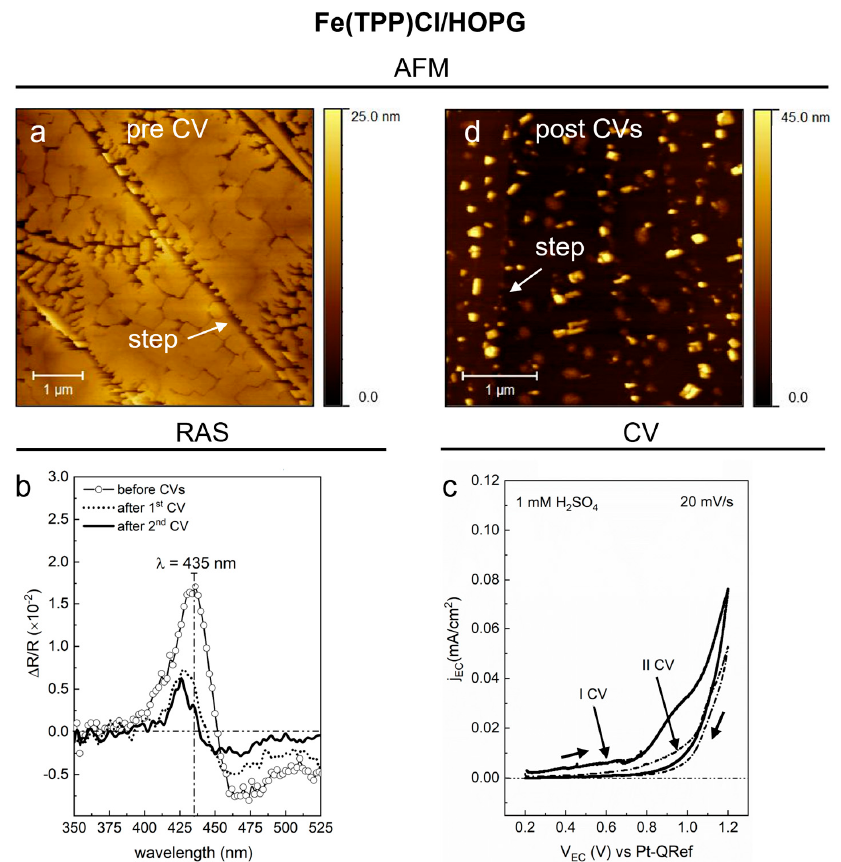
Figure 4. ( a ) (5 × 5) µm 2 topographic image of the 6 nm thick Fe(TPP)Cl/HOPG sample; the